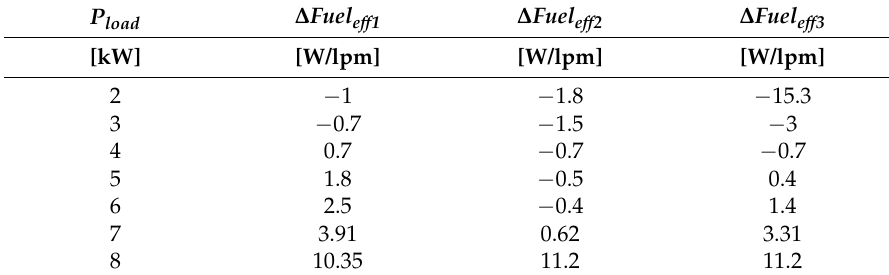
Table 3. The gaps in fuel efficiency.